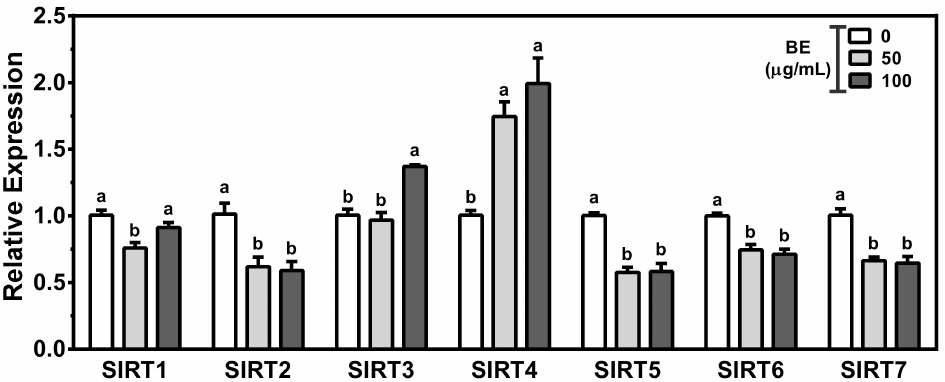
Figure 6. Modulation of SIRTs in BE-treated HepG2 cells. The cells were treated with either 50 or 100 µ g/mL of BE for 24 h. The mRNA expression of SIRT isoforms was measured by qRT-PCR. Bars with different letters are significantly different ( p < 0.05). Values are means ± S.E.M. n =